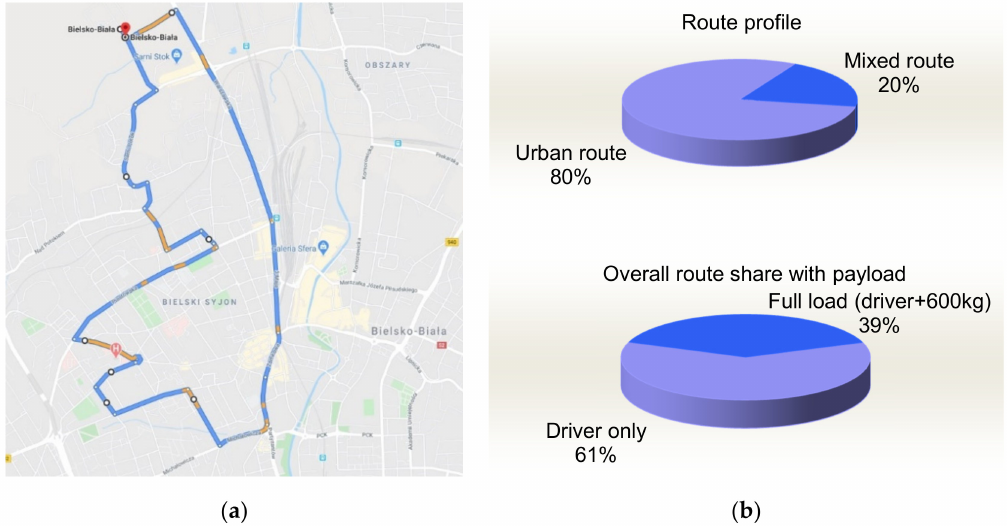
Figure 7. ( a ) Scheme of the driving loop for the vehicle range measurement and ( b ) mileage accumulation: type of route profile (top chart) and route share with payload (bottom